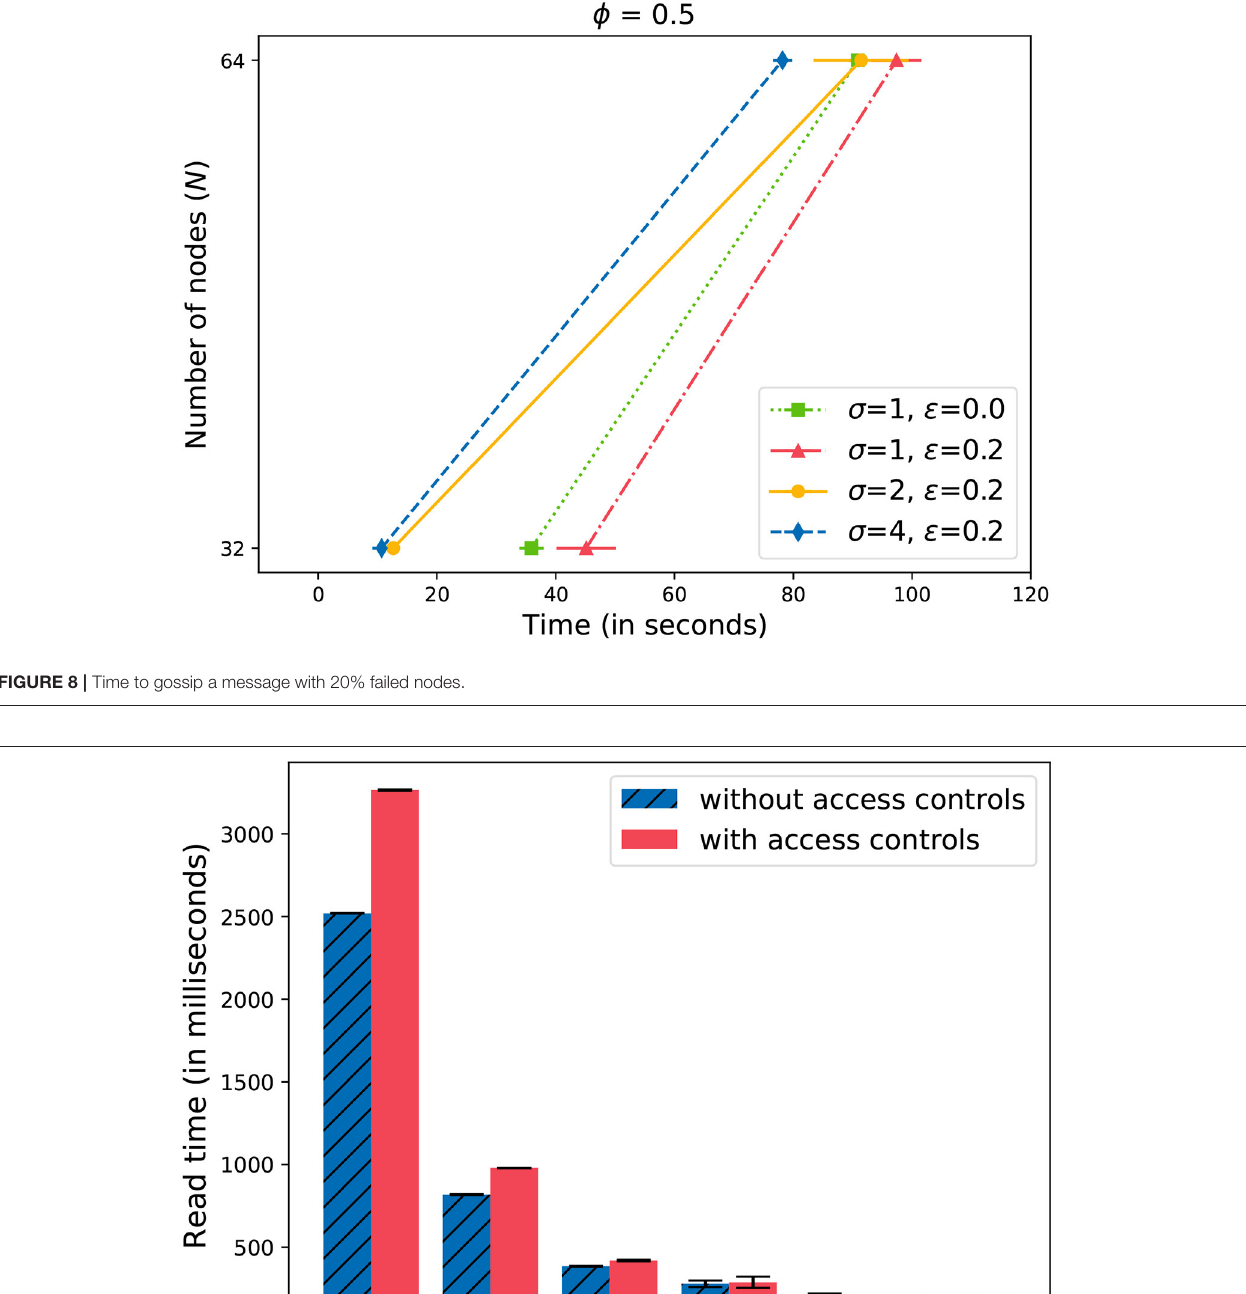
sizes on the overhead as well. The results are shown in Figure 9